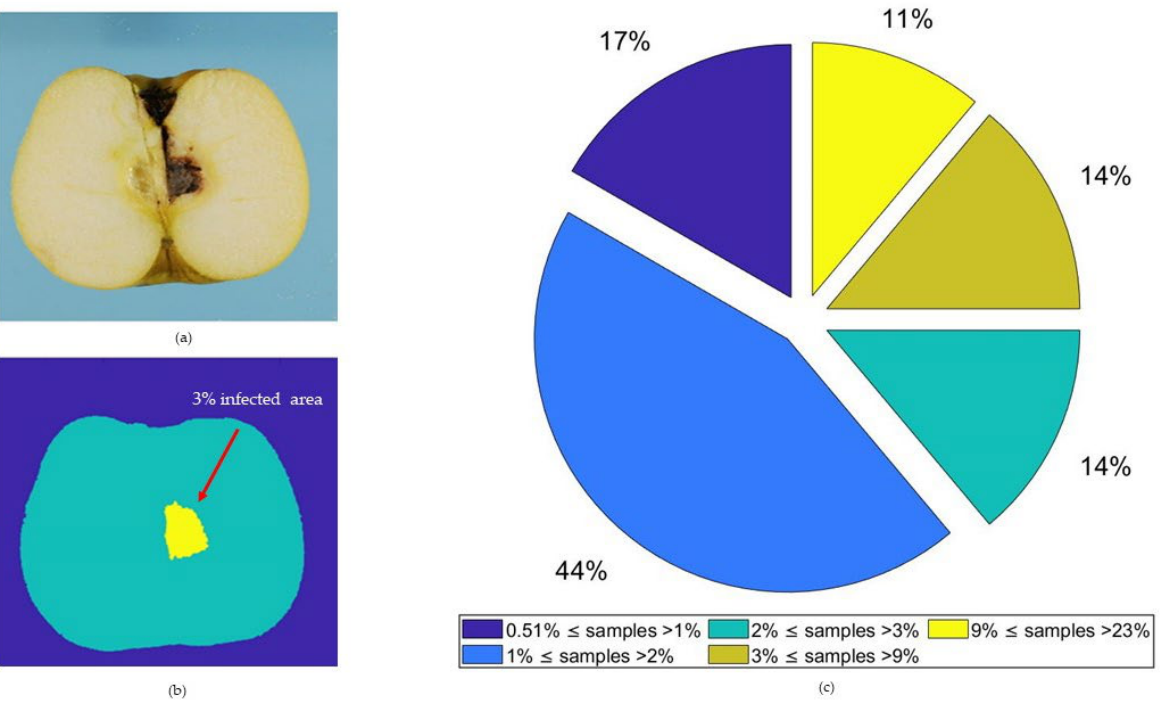
Figure 2. Example of segmentation results in a sample with a 3.0% infection rate. RGB image ( a ) was isolated from background, the results obtained ( b ) were furthermore processed to obtain necrotic area (yellow) separated from healthy area (light blue). Infection results were grouped into classes based on infection levels ( c ).